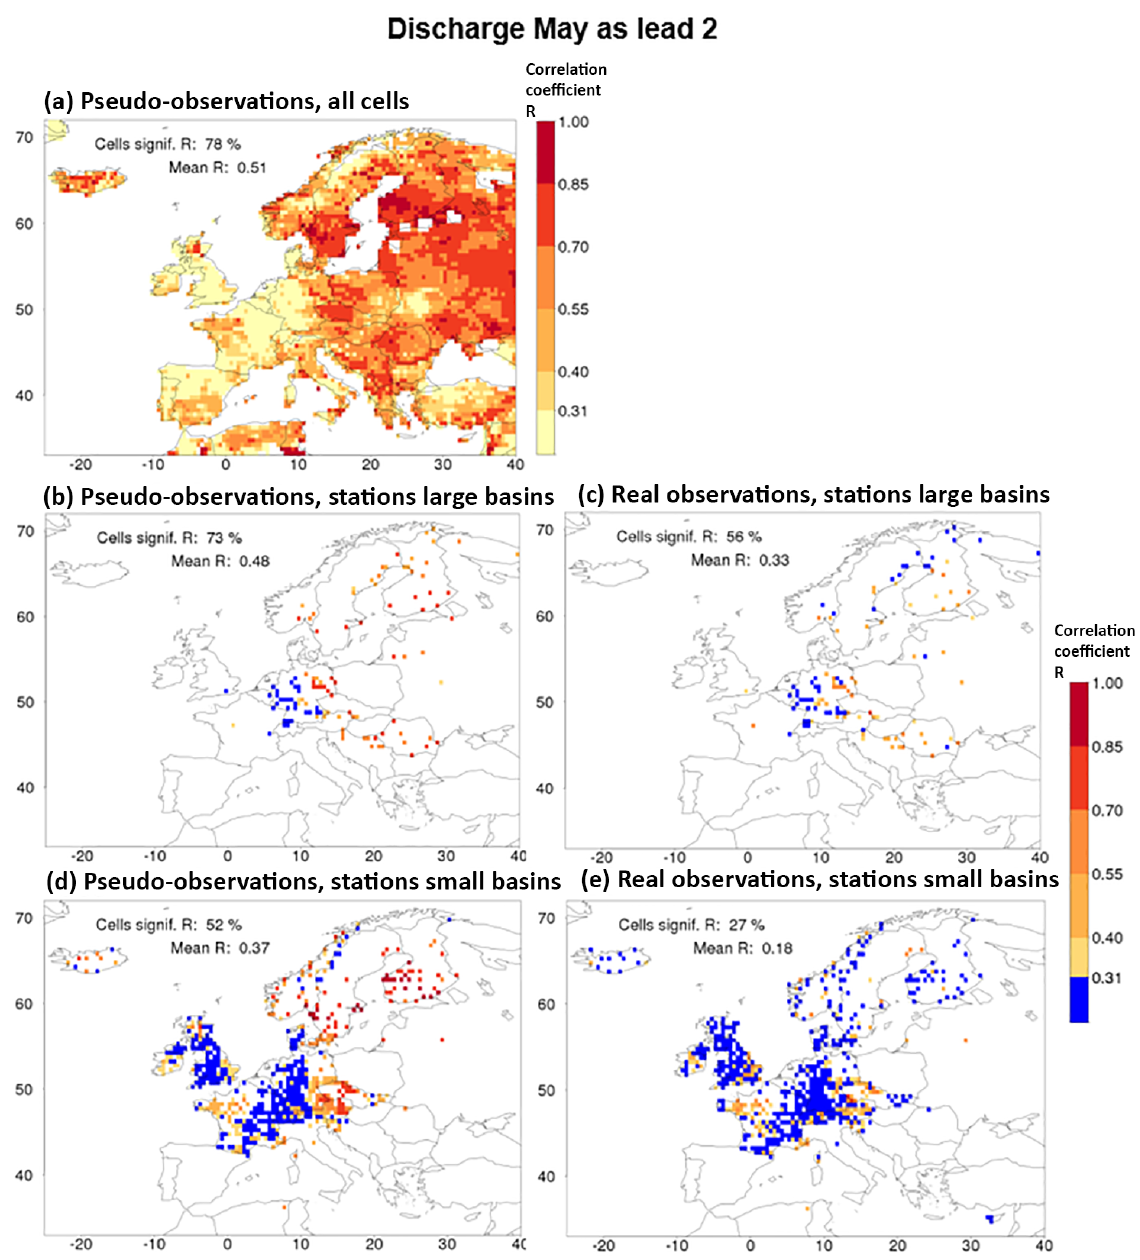
Figure 7. Skill ( R ) of the discharge hindcasts for May as lead month 2 (initialisation on 1 March). In sequence: (a) discharge verified with pseudo-observations; (b) as (a) but for cells with real observations representing large basins only; (c) discharge verified with real observations for large basins. (d) and (e) are identical to (b) and (c) , respectively, but for cells with real observations representing small basins. More explanation is given in the caption of Fig. 1, but in (d) and (e) cells with insignificant skill are coloured blue instead of yellow for better